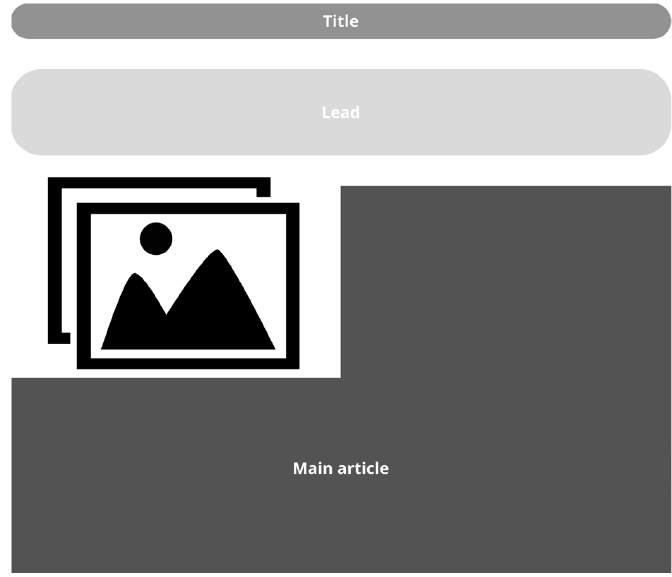
Figure 3. Example of the news structure and data used in the research.